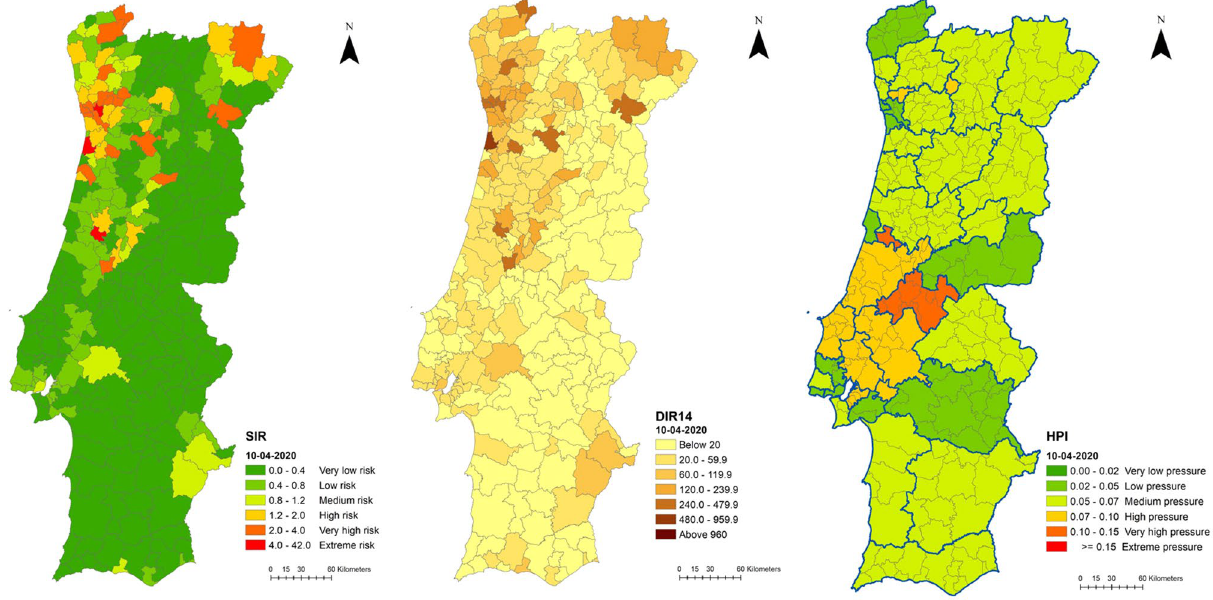
Figure 3. Spatial distribution of SIR, DIR14 and HPI, 10/04/2020, Portuguese mainland.